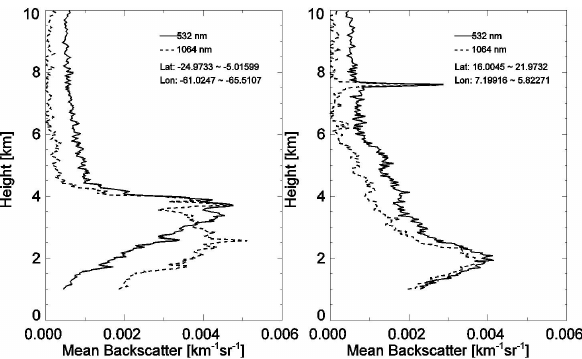
Fig. 4. CALIOP-measured attenuated backscatter profiles at 532nm (solid line) at 1064nm (dotted line) over Amazonia (left) and the Sahara